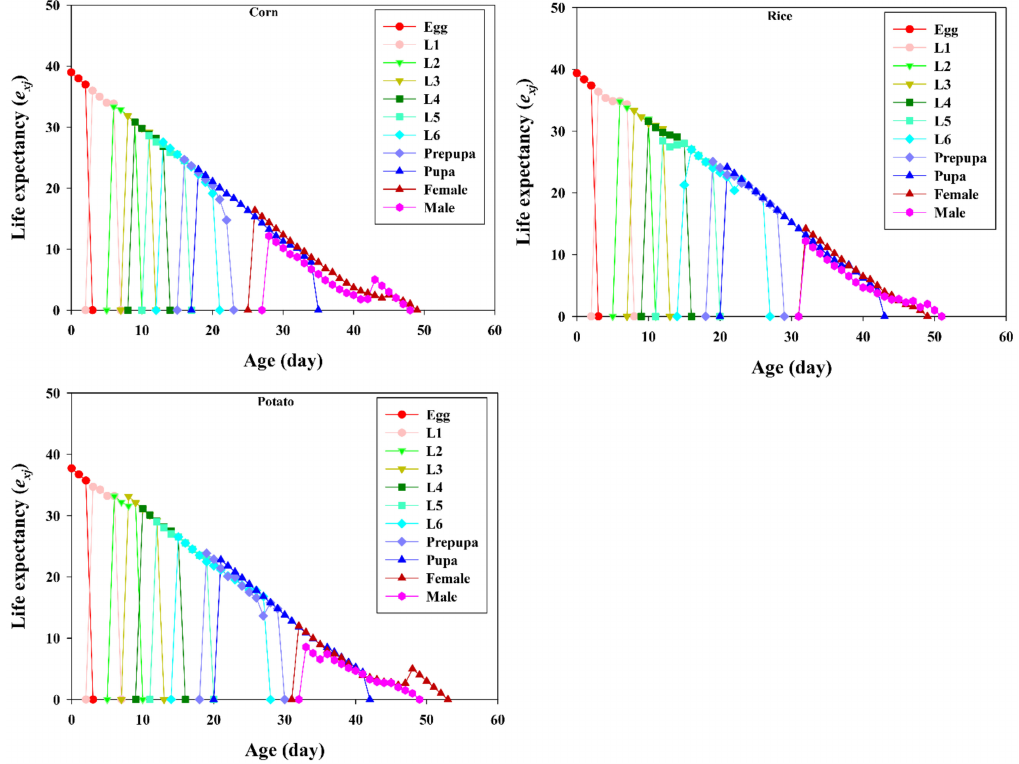
Figure 4. Age-stage-specific life expectancies ( e xj ) of Spodoptera frugiperda fed on corn, rice, and potato. L1–L6 are the larval instars from first to